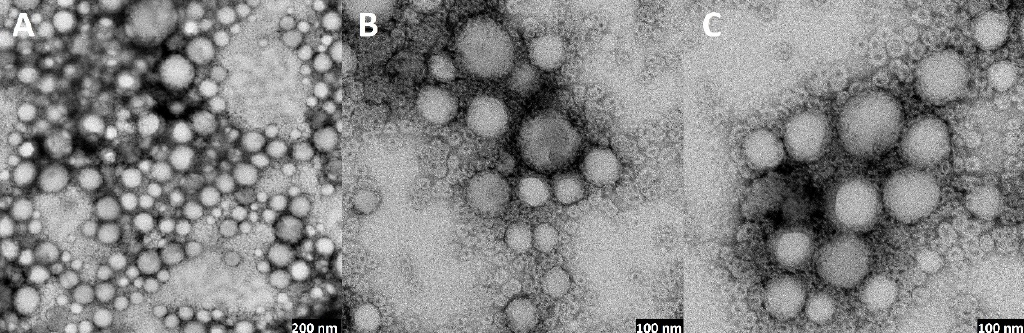
Figure 13. TEM images of UA-loaded hybrid S85-PLGA-PEG 2000 nanoparticles: ( A ): magnitude 30 k, scale bar 200 nm; ( B ): magnitude 80 k, scale bar 100 nm; ( C ): magnitude 120 k, scale bar 100 nm. Red arrows indicate lipid layers coating PLGA particles. Around the particles, there is a clearly visible layer of small phospholipid vesicles.